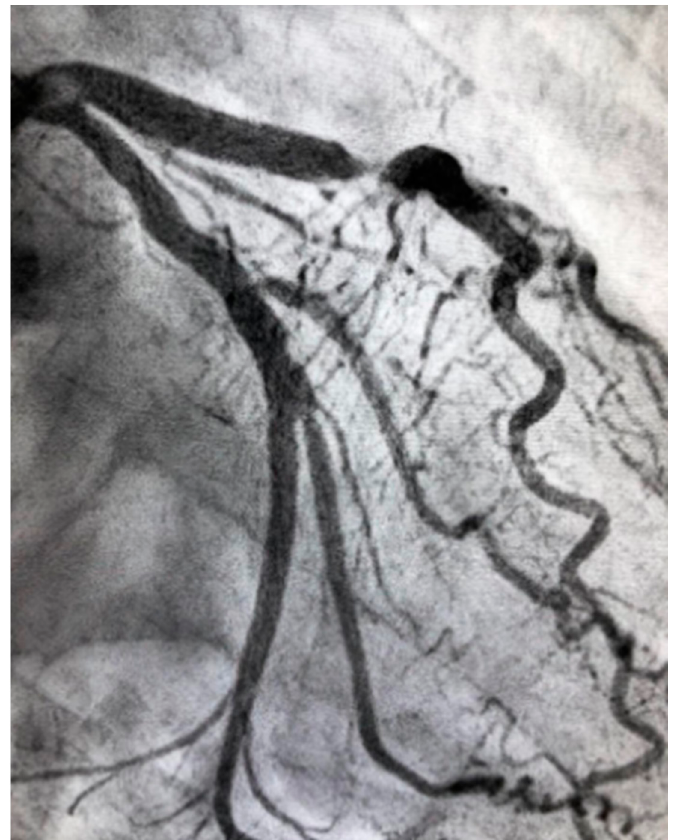
Figure 2. Severe atherosclerotic stenosis of the LAD in a female patient with ACS.